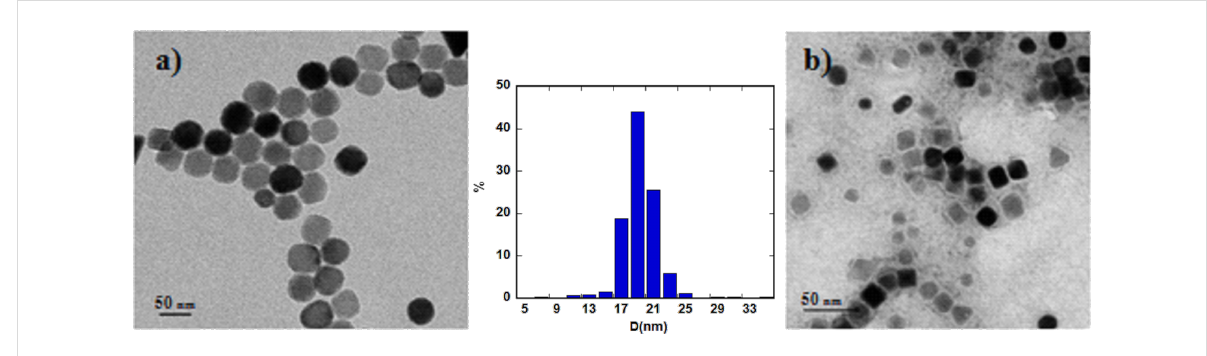
Figure 1: TEM images of a) Fe 3 O 4 @OA and b) Fe 3 O 4 @PMAO with the diameter size distribution shown between the